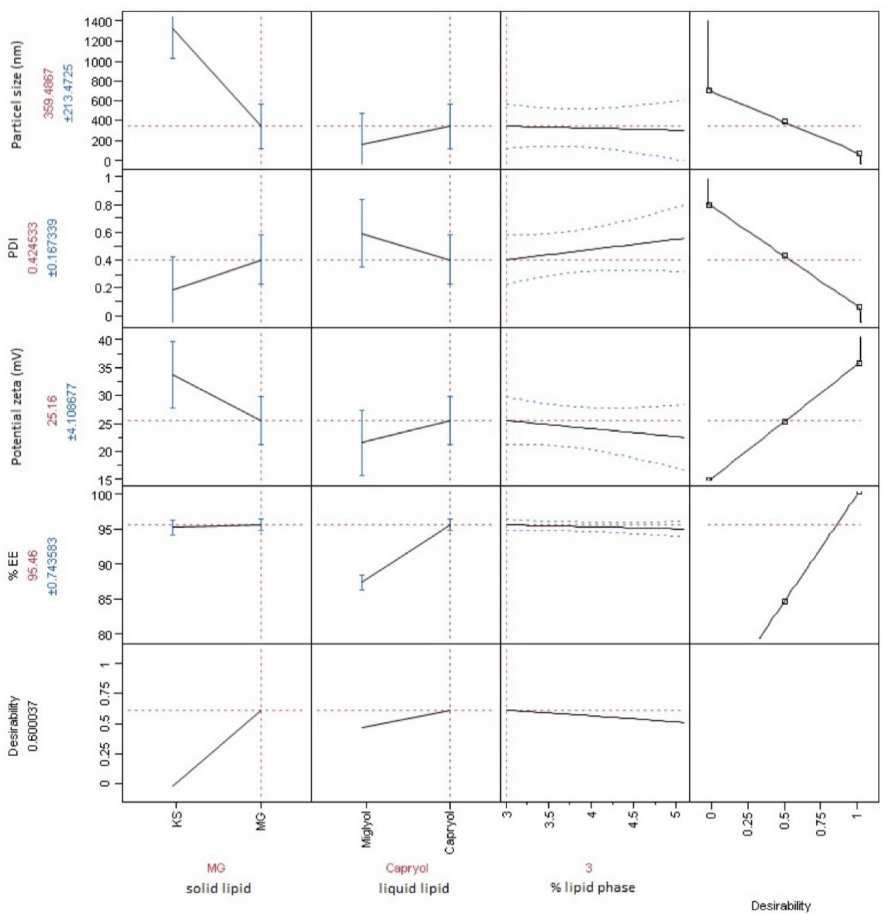
Figure 2. Optimal formulation parameters, using prediction profiler with maximum desirability